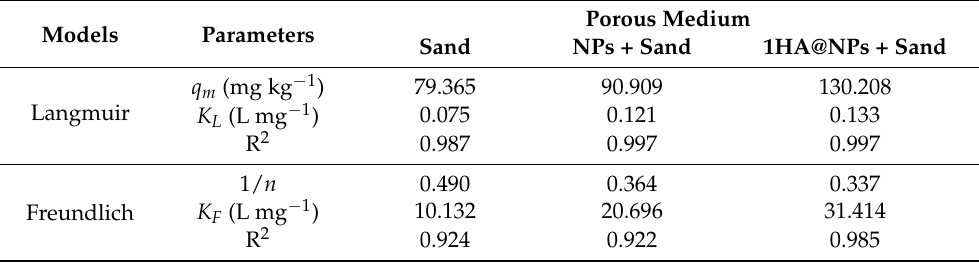
Table 3. Fitted parameters of the isotherm models for the adsorption of Cu 2+ in different media, with an IS of 5